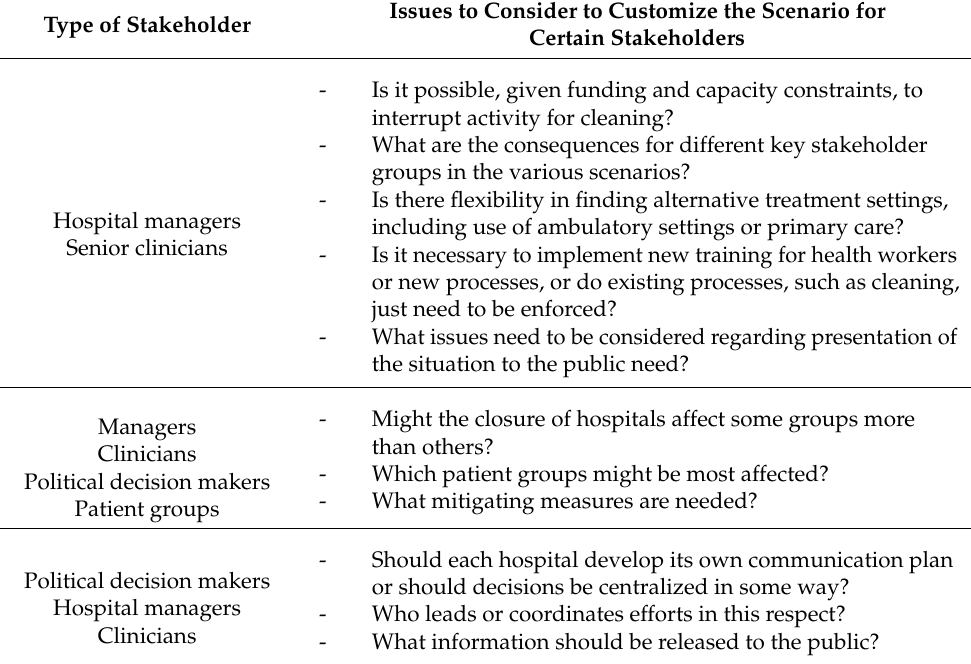
Table 3. Concern by specific stakeholder type as related to the super-bug ‘what if’ scenario to be used for further